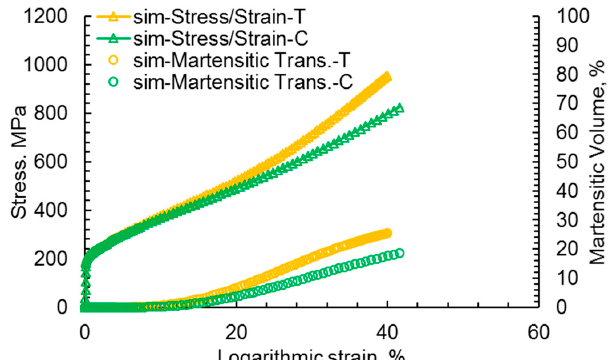
Figure 16. Numerical simulation results of the calibrated model providing information about the evolution of several microstructural phenomena attributed to increasing strain. The trends compare well with the experimentally observed acoustic emission data shown in Figure 14b (reprinted with permission from [43], MDPI, 2020).